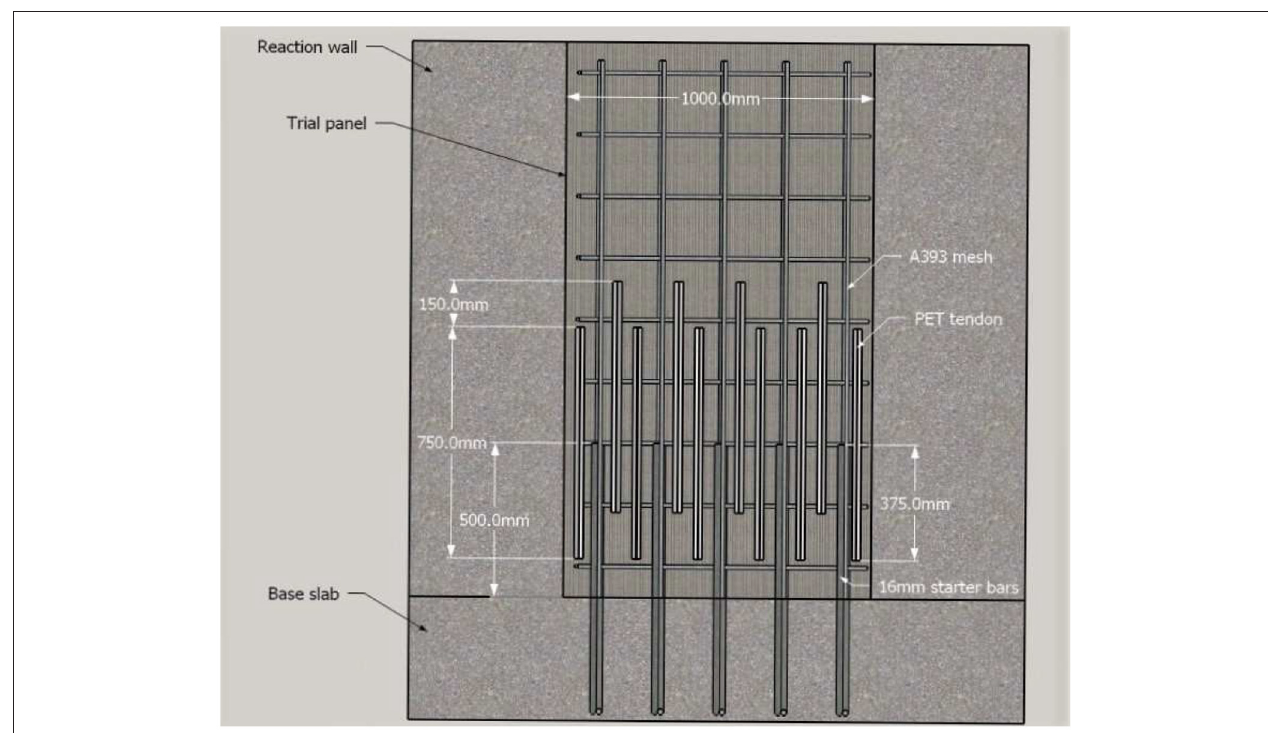
FIGURE 6 | Position of SMP tendons within Panel B.